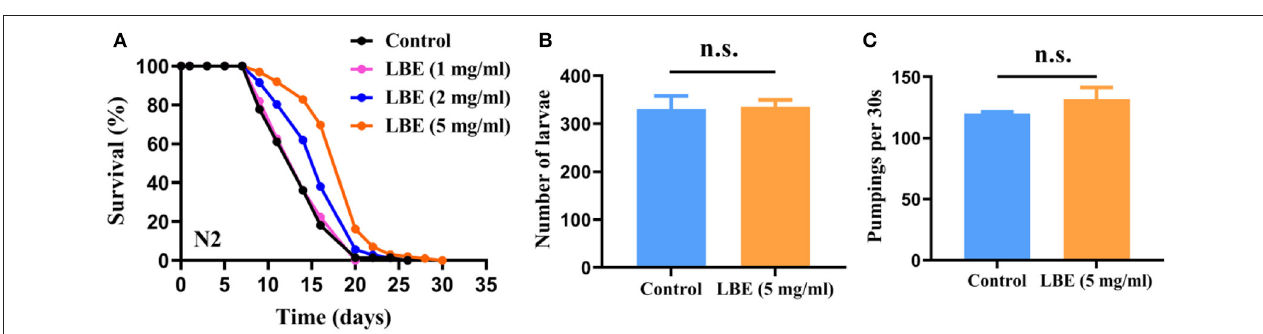
FIGURE 2 | LBE extends the lifespan of C. elegans without side effects on fertility and pharyngeal pumping. (A) Survival curves of N2 worms cultured with vehicle or 1, 2, and 5 mg/ml LBE (control: n = 49, mean lifespan 13.9 days; 1 mg/ml LBE: n = 51, mean lifespan 14.1 days, p = 0.703 vs. control; 2 mg/ml LBE: n = 91, mean lifespan 16.2 days, p = 0.002 vs. control; 5 mg/ml LBE: n = 68, mean lifespan 18.7 days, p < 0.0001 vs. control). (B) The number of larvae fertility of worms treated with vehicle ( n = 4) or 5 mg/ml LBE ( n = 4). (C) The frequency of pharyngeal pumping of worms treated with vehicle ( n = 5) or 5 mg/ml LBE ( n = 5). Error bars represent SD. The results are representative of at least two independent experiments. Log-rank test (A) or unpaired t -test (B,C) was used to assess significance. n.s., not significant. LBE, total water extracts of L. barbarum berry. LBP did not prolong the lifespan of worms at 20 ◦ C ( Figure 1A